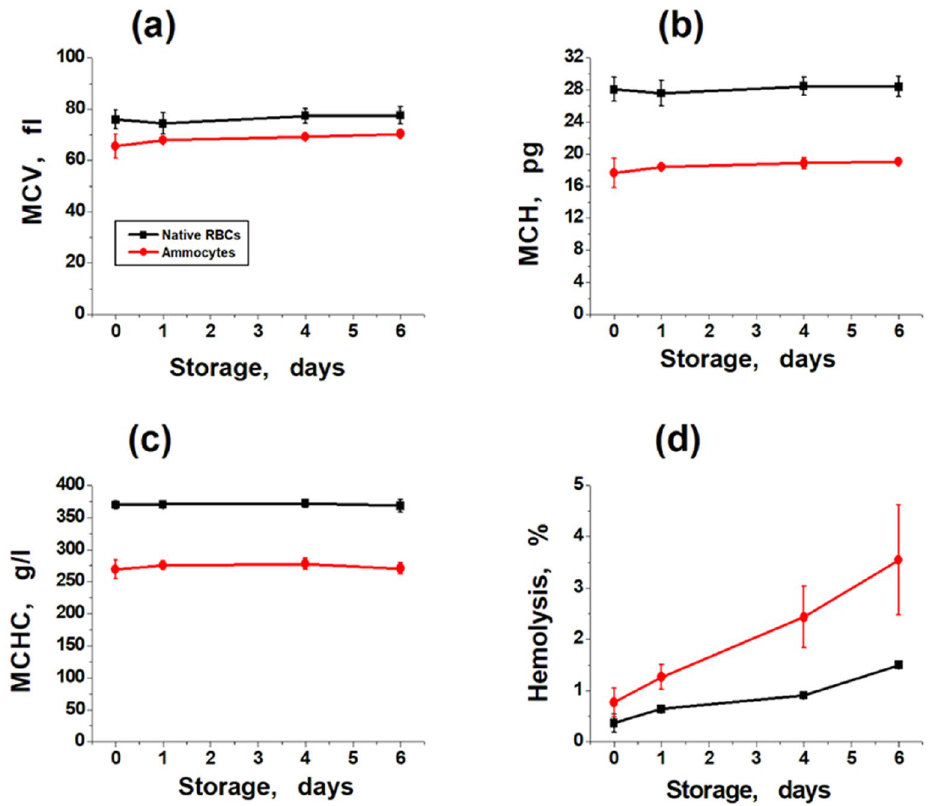
Figure 1. Erythrocyte indices and hemolysis of native RBCs and ammocytes during storage. Suspensions of native RBCs (black symbols) and ammocytes (red symbols) with a hematocrit of 10% were stored at + 4 °C for 6 days. ( a ) Mean cell volume (fl). ( b ) Mean cell hemoglobin content (pg). ( c ) Mean cell hemoglobin concentration (g/l). ( d ) Hemolysis of ammocytes and native cells during storage. Mean values ± SD are presented. For all erythrocyte indices, n = 5 (except for day 0, where n = 7). For hemolysis of ammocytes n = 4, except for day 0 (n = 5), for hemolysis of native cells n = 12, except for day 0 (n =